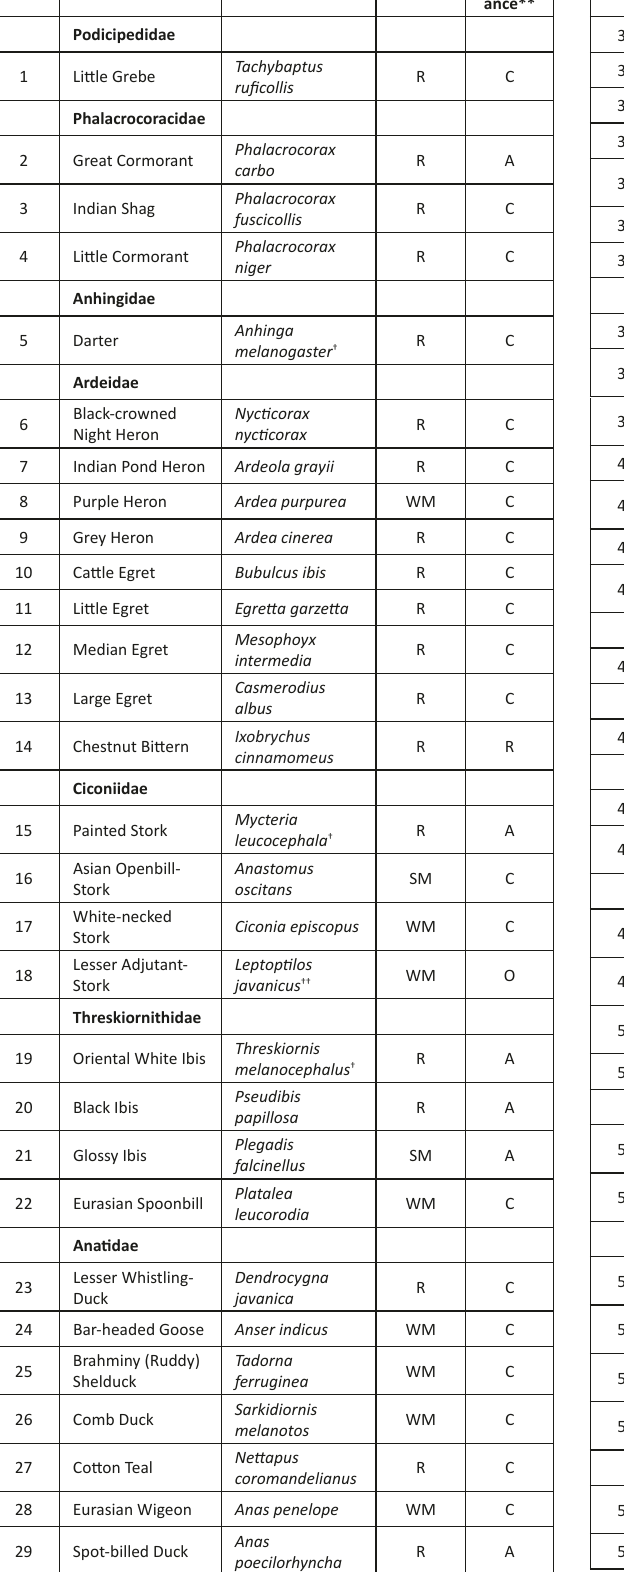
Table 1. List of birds of Manjeera Wildlife Sanctuary, Andhra Pradesh,